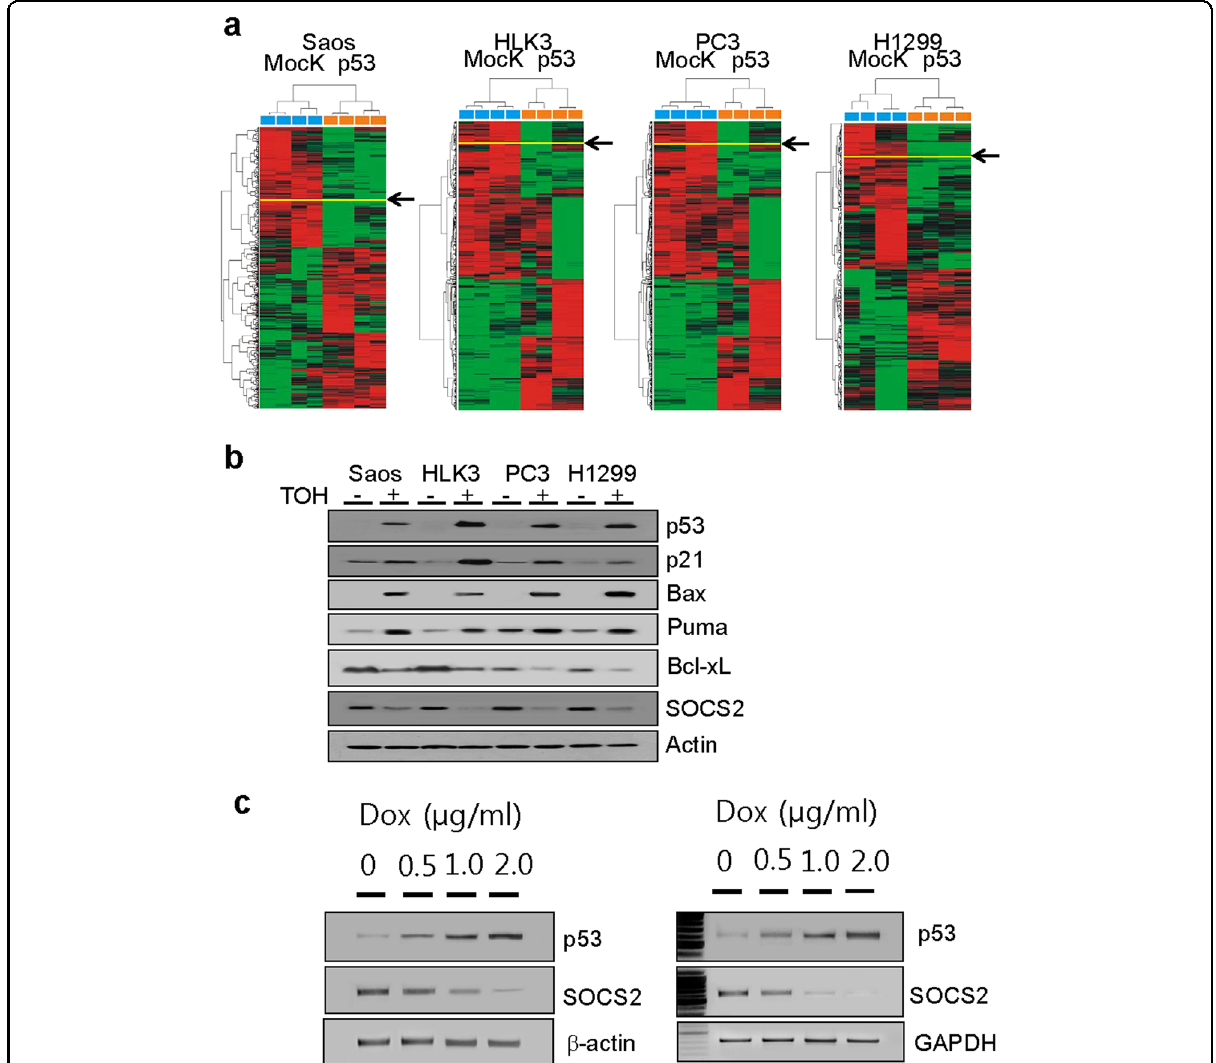
Fig. 1 SOCS2 expression in p53-inducible cells. a Unsupervised hierarchical clustering separated samples into two groups: mock and p53. SOCS2 had a twofold or greater expression difference from mean at P < 0.05 based on t tests for hierarchical clustering. Data are presented in matrix format. Columns are individual cell lines and rows are genes. Red, high expression; green, low expression; black, no signi fi cant expression change between mean and sample. b Levels of SOCS2 and various p53 target proteins were analyzed by immunoblot of four p53-inducible lines (Saos, HLK3, PC3, and H1299). p53-null cells were transfected with inducible p53 plasmids (p53ER TM ) and immunoblot analysis after 5 µM 4-OH tamoxifen, 24 h. c Protein (left panels) and mRNA expression levels (right panels) of SOCS2 were inversely regulated by endogenous p53 expression in HCT116 p53(+/+) cells. Dox